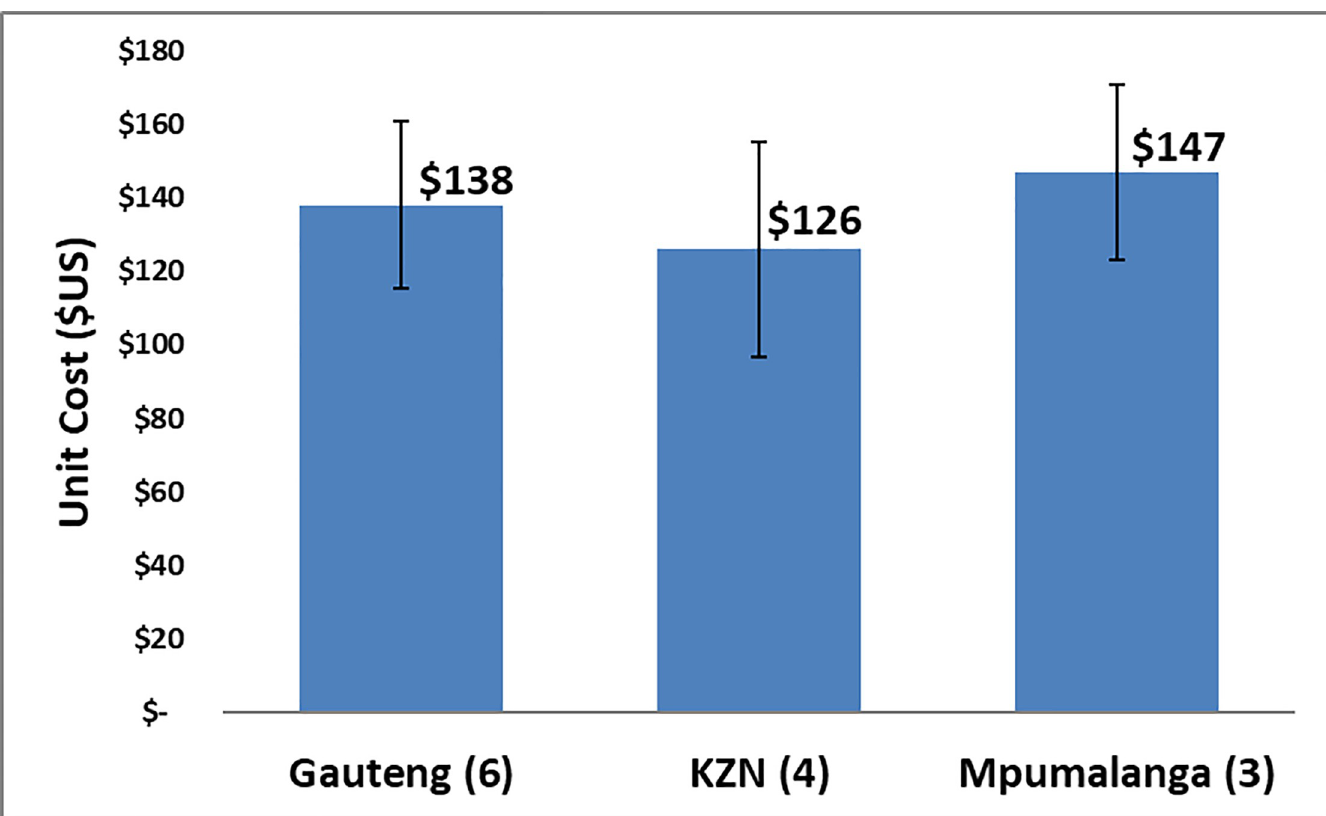
Fig 4. Unit cost by province urbanization